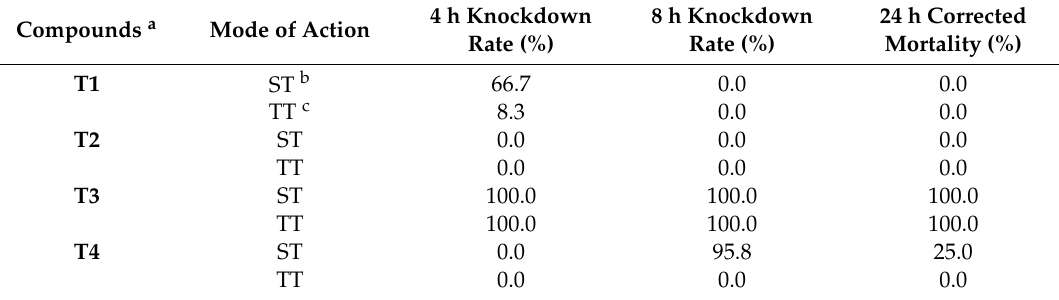
Table 2. Toxicity of compounds against M.